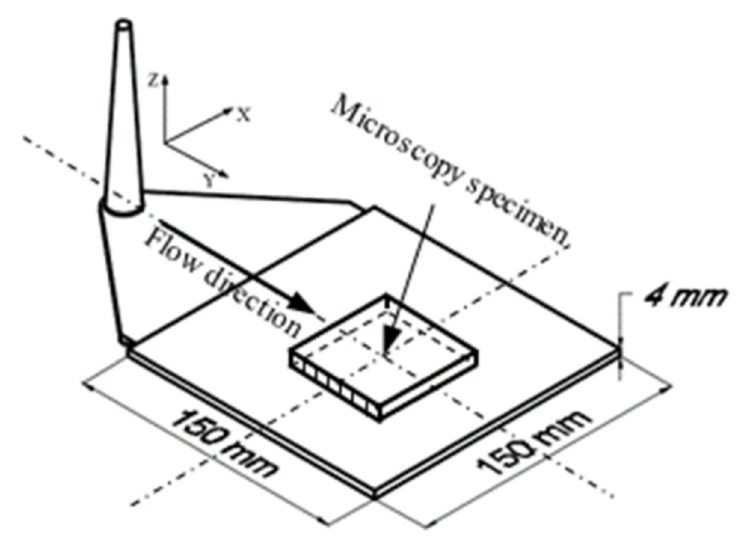
Figure 4. Position of specimens for analyzing fiber